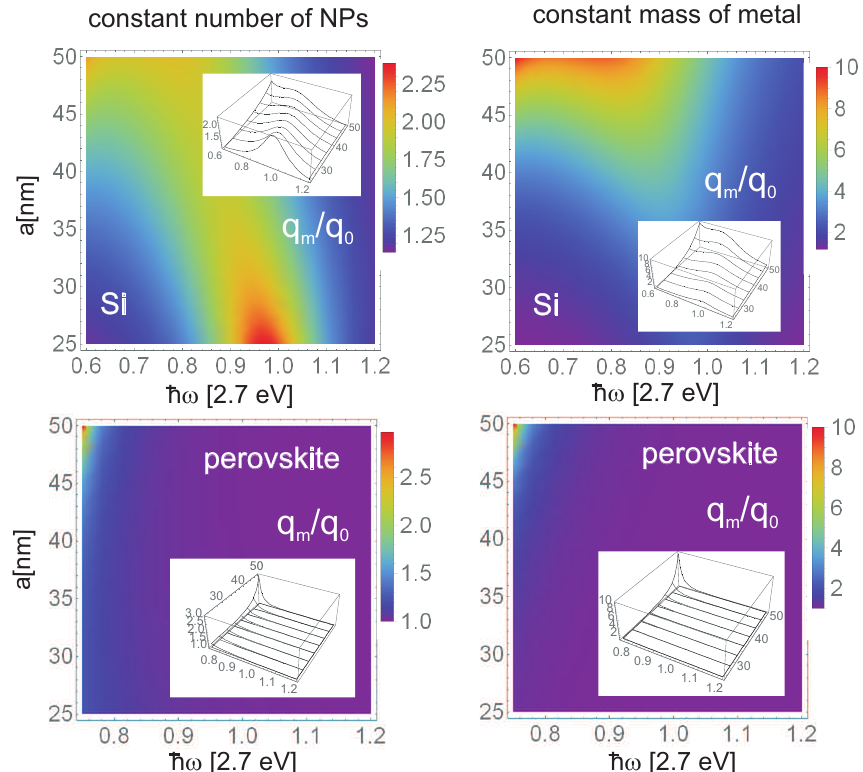
Figure 5. Spectral dependence of the efficiency increase q m (the ratio of probabilities of q 0 inter-band transitions per single photon with energy ¯ h ω , with and without metallic nanoparticles (NPs)—according to Equation (17) and data listed in Tables 1–3) for Si cell (upper) covered with bare Au NPs with radii a 25–50 nm. Similar spectral dependence of the efficiency increase q m for q 0 ∈ perovskite cell (lower) with core–shell NPs of the same size as for Si samples. Left panels correspond to a concentration of NPs kept constant when their size is varying, whereas the right panels correspond to the total mass of all metallic components kept constant. The significant difference is noticeable—for perovskite cells, the metallic NPs almost do not enhance the efficiency contrary to the Si cell, which is the result of inconveniently large effective masses of carriers in the perovskite and raises its forbidden gap in comparison with Si, entering the relation